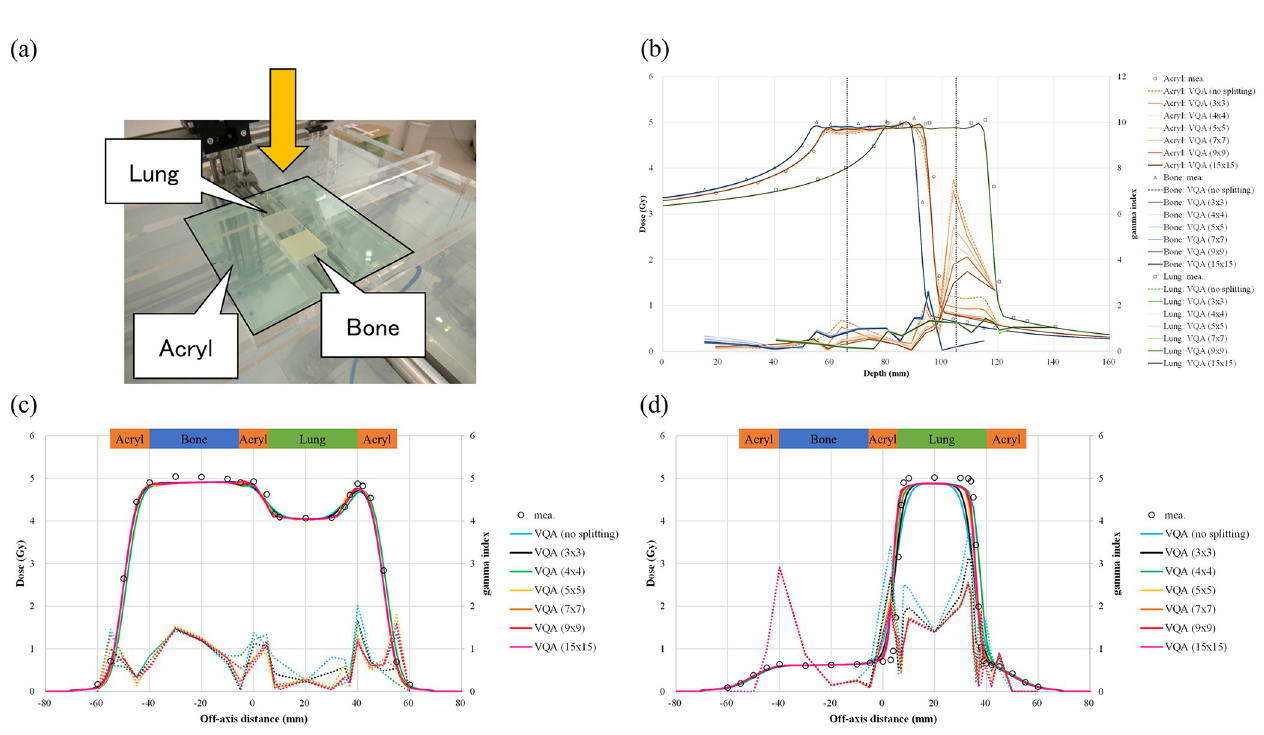
Fig 9. Results of the scanned-beam model compared with measurements in heterogeneous media. (a) The heterogeneous phantom and measurement setup; the yellow arrow represents the incident beam’s direction. (b) The depth–dose profile penetrating each material; the circle, triangle, and square represent measurements in the acrylic, bone, and lung materials, respectively. The orange, blue, and green solid lines are the calculated profiles in acrylic, bone, and lung materials, respectively. The color in the legend of calculations changes according to the number of beam splittings. The vertical black dashed lines represent the measured lateral profile positions. (c and d) Lateral-dose profiles at 66 and 105 mm, respectively; the circles represent the measured profile, whereas the sky blue, blue, green, light yellow, yellow, orange, and pink solid lines are the calculated profiles with no splitting and with beam splittings 3 × 3 (default), 4 × 4, 5 × 5, 7 × 7, 9 × 9, and 15 × 15, respectively. The right vertical axis indicates the gamma value of 1D local-gamma-index analysis at a distance-to-agreement of 2 mm and a dose difference of 2%, with a 10% threshold.